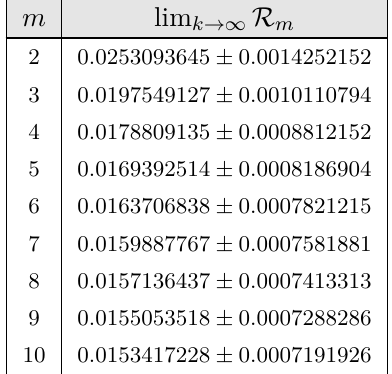
Table 11. The k → ∞ values of the Rényi entropies associated with the state | 6 1 # T 2 , 2 i .